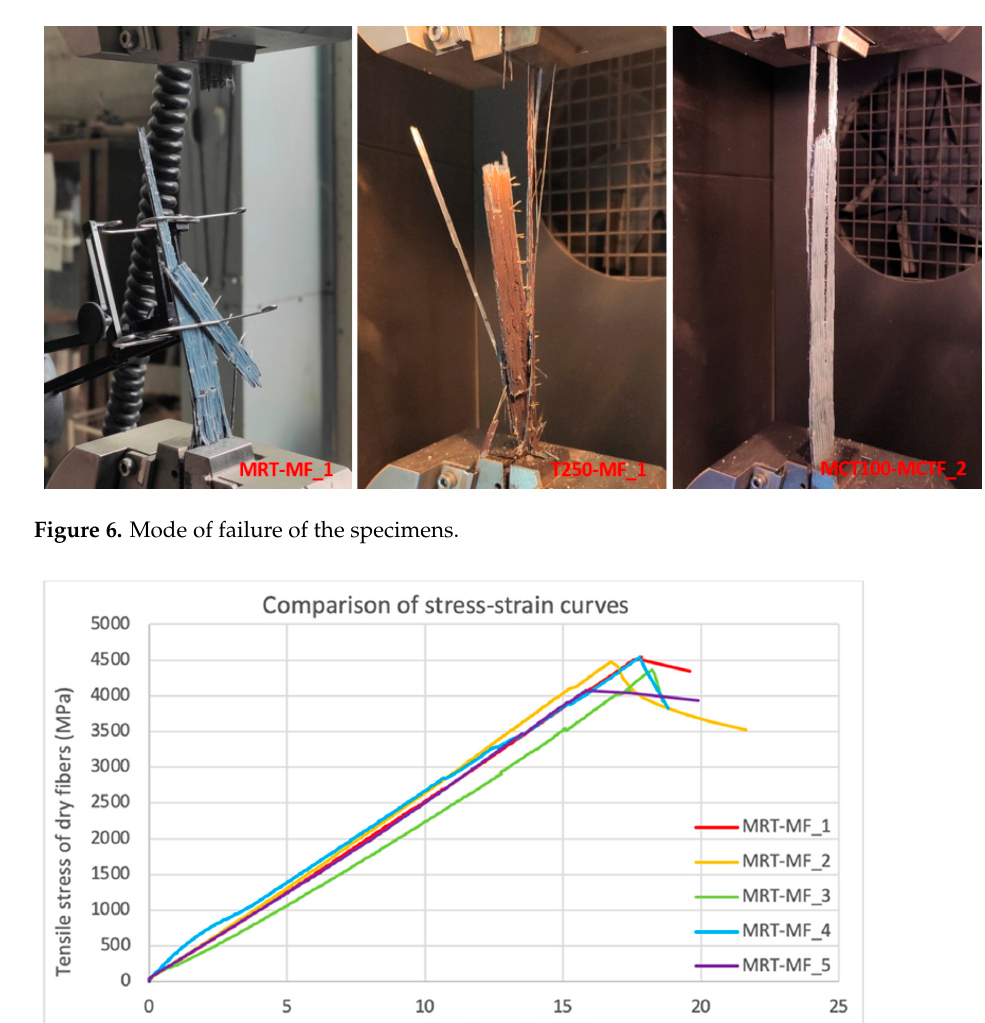
Figure 7. Stress–strain curves for monotonic uniaxial tension at room temperature.